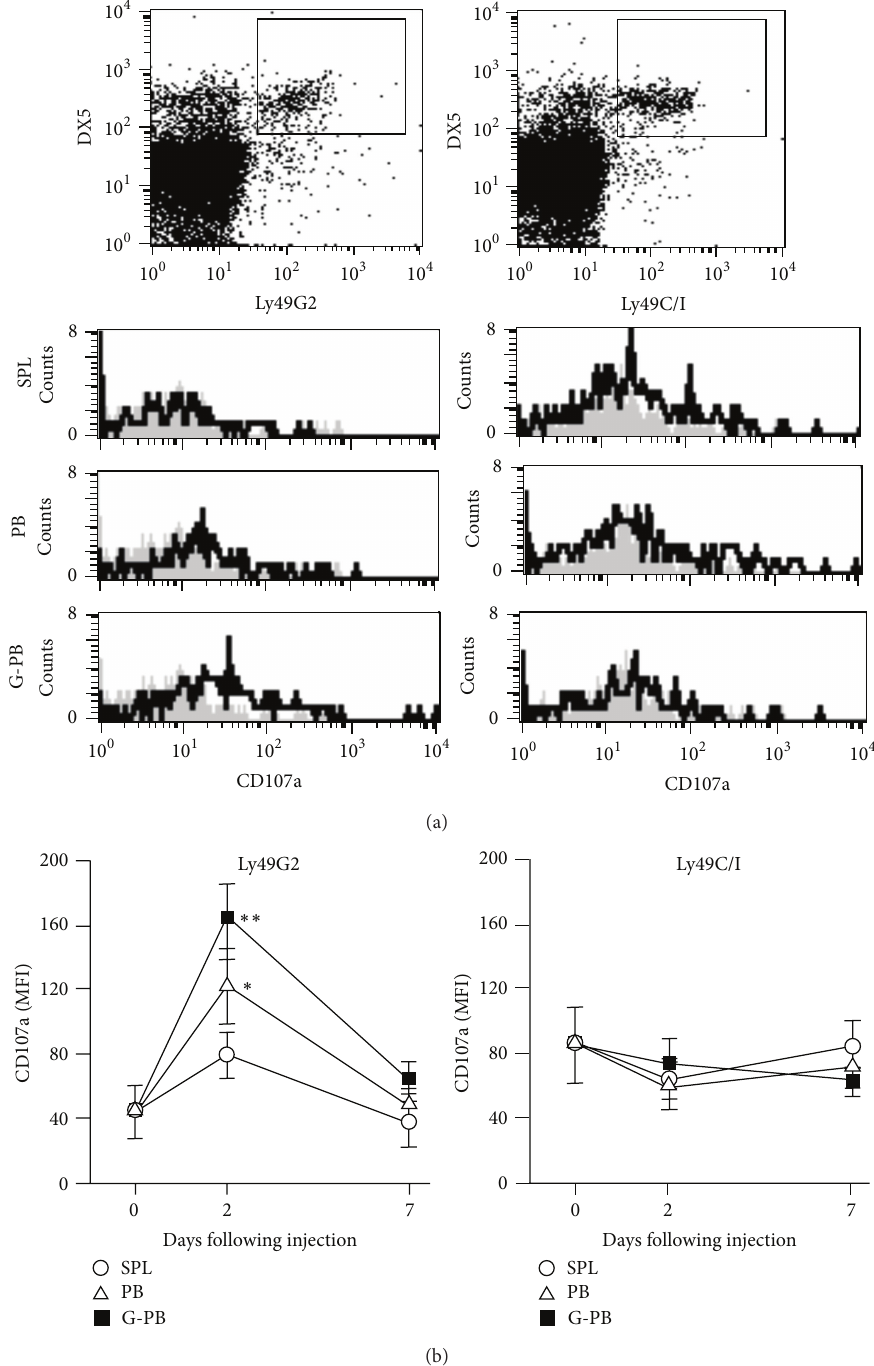
Figure 2: Neutrophils promote a licensing effect of NK cells: CD107a degranulation assay. Forty Gy-irradiated 2 × 10 6 mononuclear cells (splenocyte, SPL; peripheral blood, PB; and G-CSF-treated PB, G-PB) of B10.D2 mice were injected intraperitoneally into B10 mice. Two days after injection of cells, peripheral blood mononuclear cells of recipient B10 mice were analyzed by flow cytometry. Representative histograms show CD107a expressions gated on DX5 + CD3 − Ly49G2 + cells ((a), left) and DX5 + CD3 − Ly49C/I + cells ((a), right) in treated B10 mice (solid line) and untreated as controls (shadow area). Time course of mean fluorescence intensity (MFI) of CD107a expressions of DX5 + CD3 − Ly49G2 + cells ((b), left) and DX5 + CD3 − Ly49C/I + cells ((b), right) was analyzed before ( 𝑛 = 11 ) and after injection of SPL (open circle, 𝑛 = 18 ), PB (open triangle, 𝑛 = 18 ), and G-PB (filled square, 𝑛 = 8 ). Data are expressed as the means ± SD. ∗ 𝑃 < 0.05 ; ∗∗ 𝑃 < 0.01